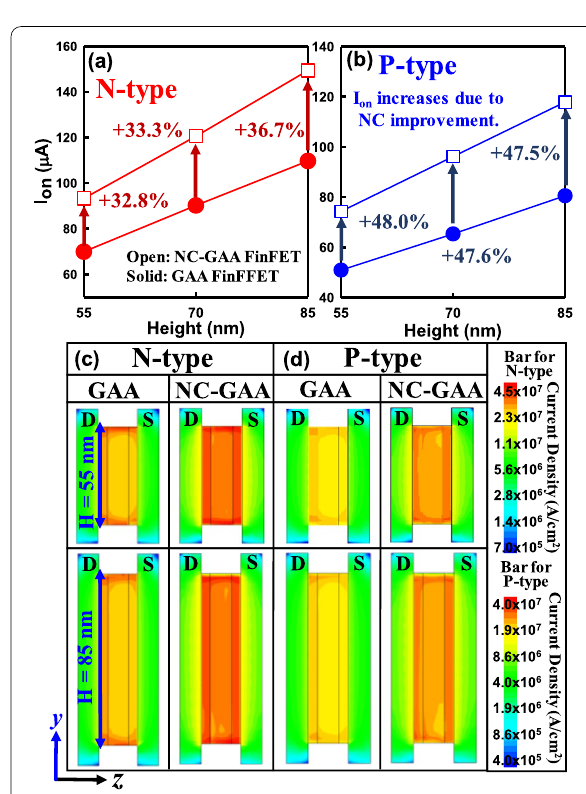
Fig. 5 The comparison of I on for a N‑/, b P‑type GAA/NC‑GAA FinFETs. Because the metal sidewall can reduce the S/D resistance, the I on is increased as the fin height increases. The current density of c N‑/, d P‑type GAA and NC‑GAA FinFETs at the fin heights of 55 and 85 nm,